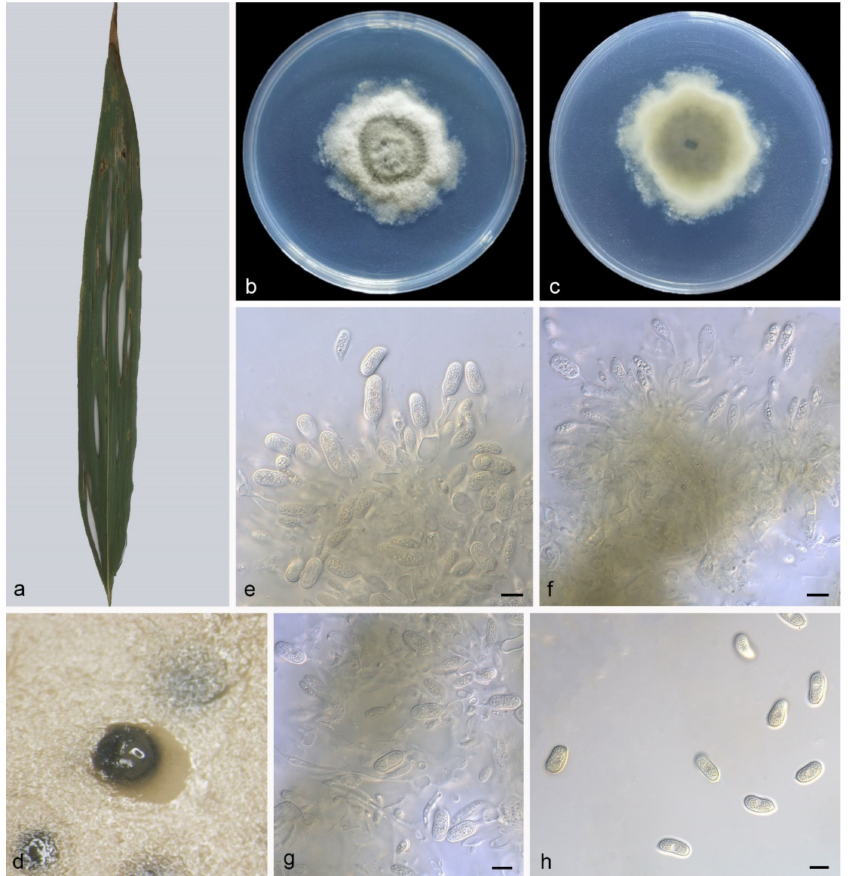
Figure 6. Pseudoplagiostoma bambusae (holotype HMAS 352300). ( a ) leaves of host plant; ( b , c ) inverse and reverse sides of colony after 15 days on PDA; ( d ) colony overview; ( e – g ) conidiogenous cells with conidia; ( h ) conidia. Scale bars: ( e – h ), 10 µ